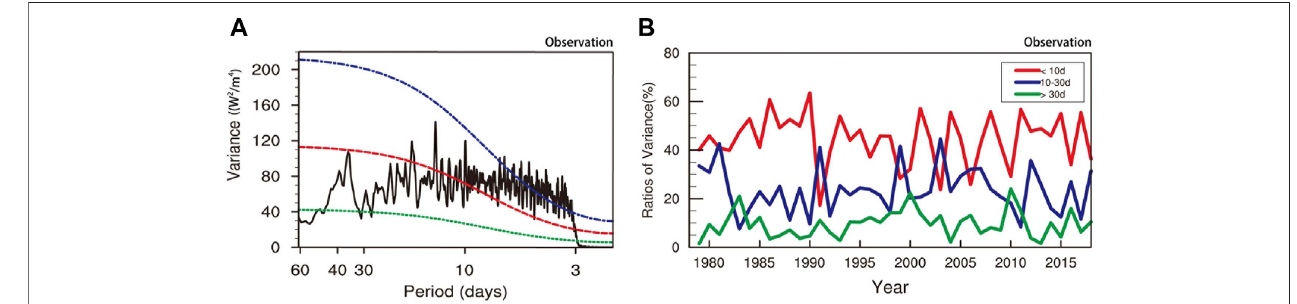
FIGURE 2 | (A) Power spectrum analysis of precipitation from June to July of 1979-2018 (units: W 2 m − 4 ). The red dashed line is the red noise spectrum, and the blue (green) dashed line indicates values above the 95% (5%) con fi dence level (B) Variance contributions of precipitation components at different time scales to precipitation anomalies (red, synoptic scale; blue, quasi-biweekly scale; green, background scale).